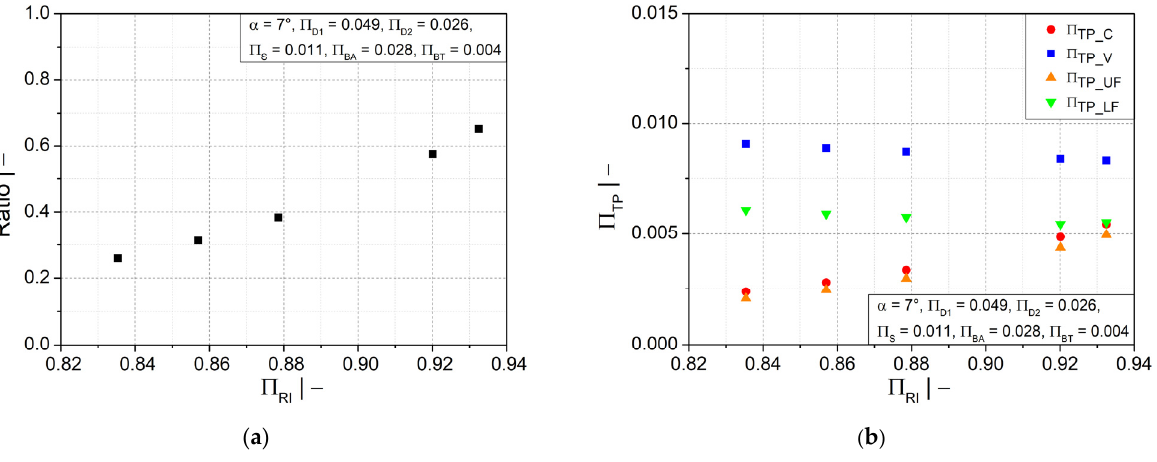
Figure 11. ( a ) Ratio of wall thicknesses at crest and valley and ( b ) dimensionless wall thickness as functions of dimensionless mold block inner radius ∏ R